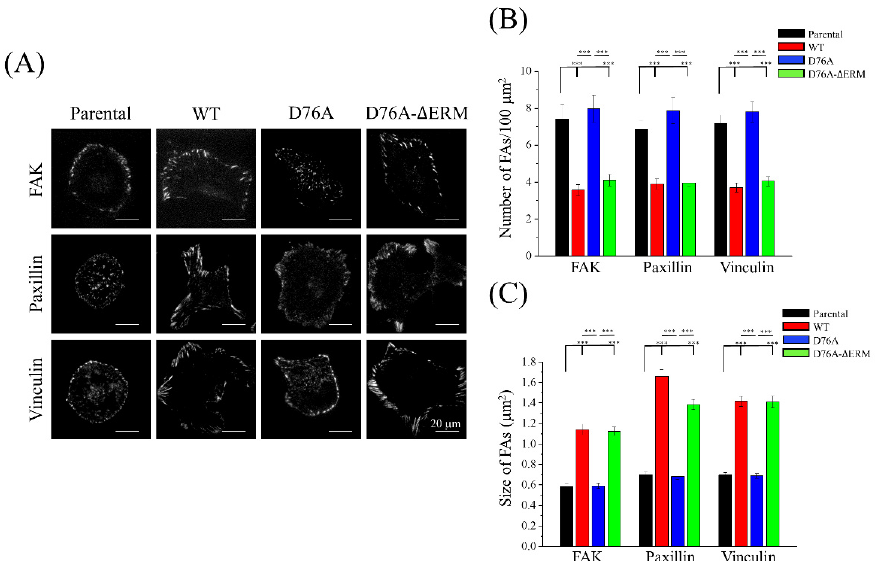
Figure 5. Overexpression of different STIM1 variants affects the focal adhesion dynamics. ( A ) Images of immunofluorescence-stained focal adhesion proteins, including FAK, paxillin and vinculin, were taken and observed under TIRF microscope. The exposure time was fixed in all of the images. ( B , C ) Quantification of the number and size of focal adhesion proteins in cells expressing different STIM1 variants. Bars represent the mean ± SEM. *** p < 0.001 by one-way ANOVA.